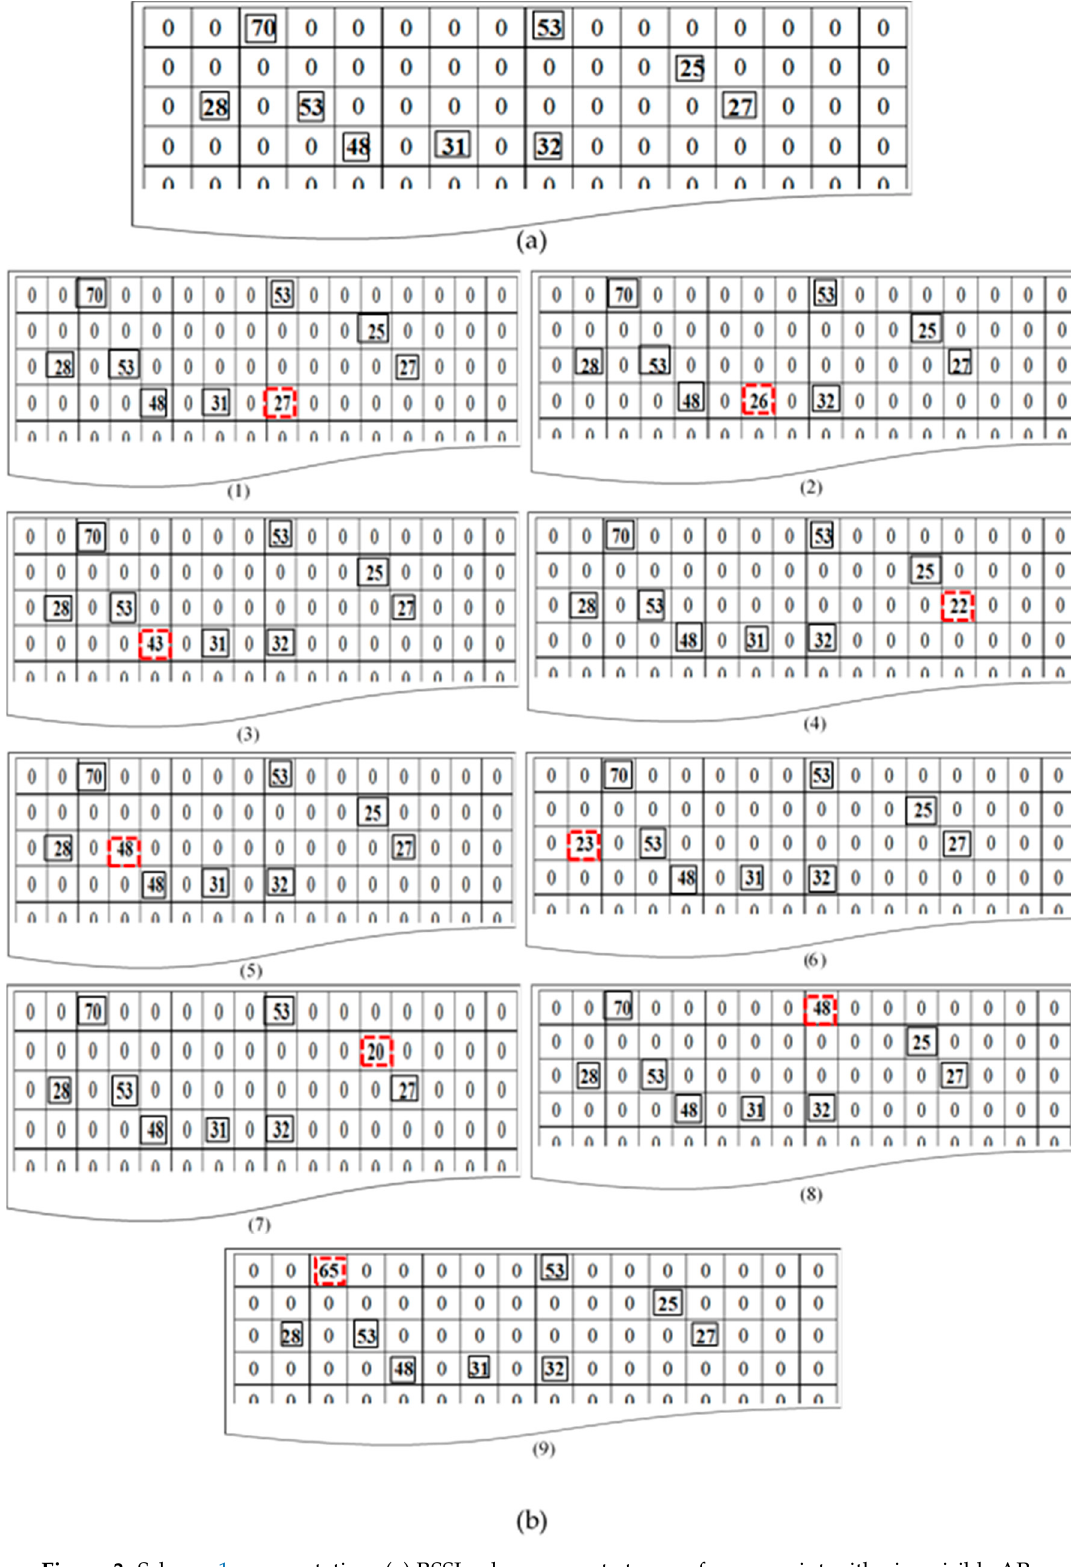
Figure 3. Scheme 1 augmentation: ( a ) RSSI values present at one reference point with nine visible APs. ( b ) The augmented data set with nine copies and changes in only one RSSI value by 5. The solid boxes represent RSSIs without any change, while the dotted red box represent RSSIs with a difference of 5.